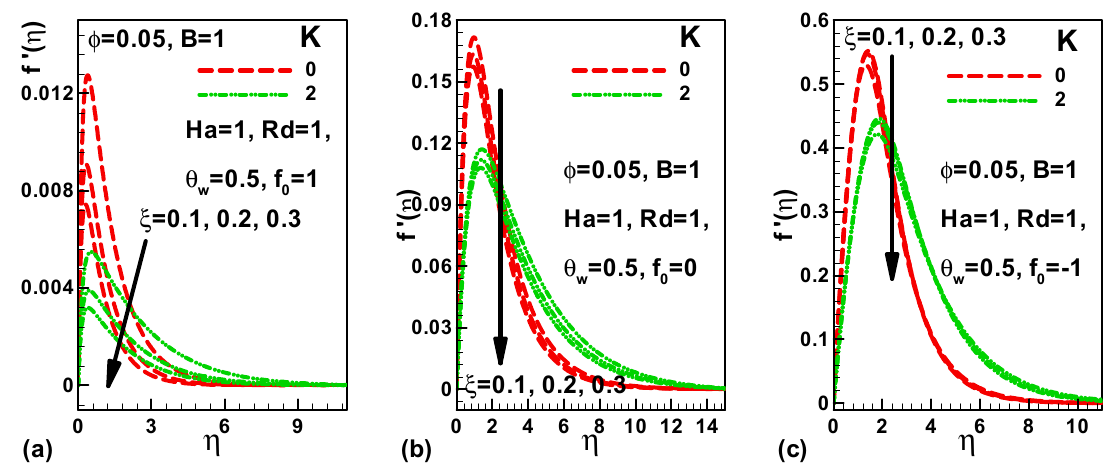
Figure 2. Effects of micropolar parameter on dimensionless velocity along truncated cone for ( a ) suction, ( b ) impermeable, and ( c ) injection of kerosene-based magnetite nanofluid.